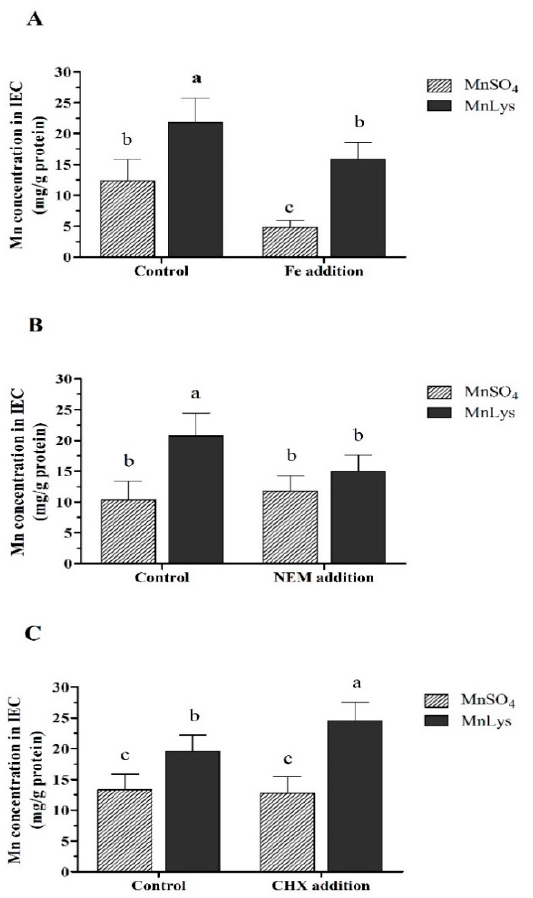
Figure 3. The uptake of manganese (Mn) from MnSO 4 and Mn-lysine (MnLys) complex in the primary chicken intestinal epithelial cells (IEC). ( A ) Effect of iron (Fe) addition on the uptake of Mn from different Mn sources. The cells were treated with 0 (control) or 1.50 mM Fe (Fe addition) and 0.25 mM MnSO 4 or MnLys for 60 min. ( B ) Influences of N-ethylmaleimide (NEM) on the uptake of Mn from different Mn sources. The cells were pretreated with 5 μ M NEM for 10 min and then were treated with 0.25 mM MnSO 4 or MnLys for 60 min in the presence of NEM. ( C ) Influences of cycloheximide (CHX) on the uptake of Mn from different Mn sources. The cells were pretreated with 5 μ M CHX for 10 min and then were treated with 0.25 mM MnSO 4 or MnLys for 60 min in the presence of CHX. Interaction of Mn source and Fe, NEM, or CHX treatment influenced ( p < 0.05) Mn uptake in primary chicken IECs. Values are least-square means ± standard error ( n = 8). a–c Mean values lacking a common letter are different at p < 0.05.